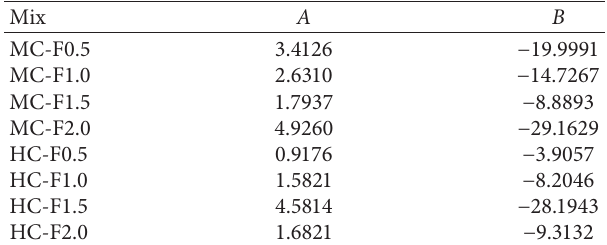
Figure 9: Dynamic increase factor for high strength SFRSCC. Table 4: Constants in proposed DIF formula for